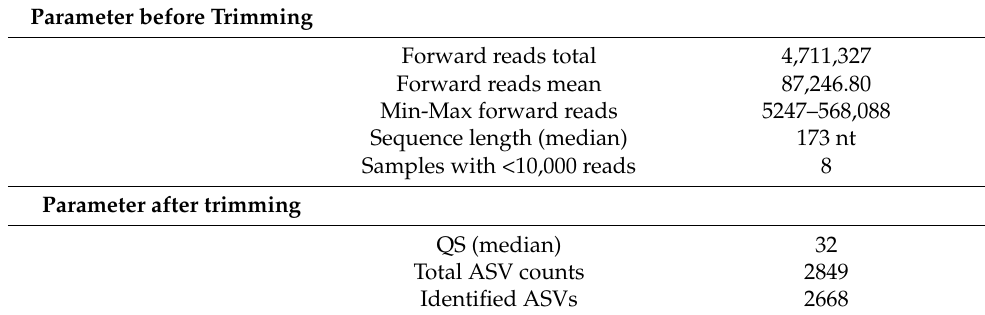
Table 3. Ion torrent semiconductor DNA sequencing summary ( n = 54).